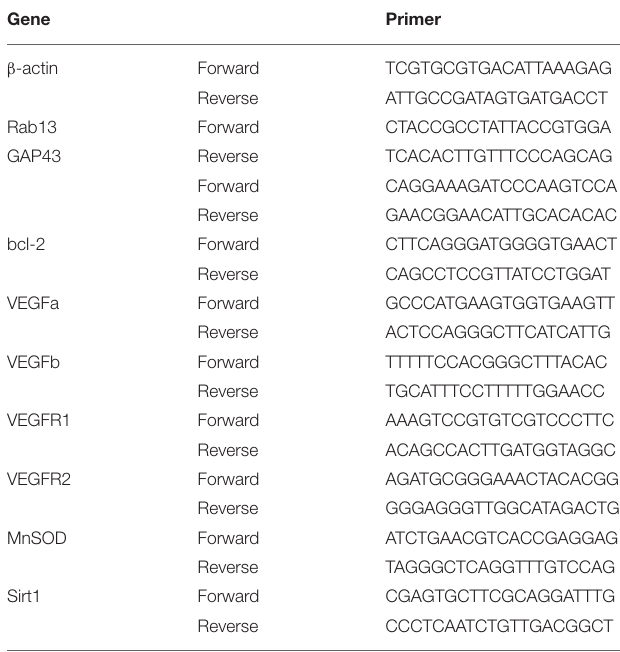
TABLE 2 | Primers for real-time quantitative polymerase chain